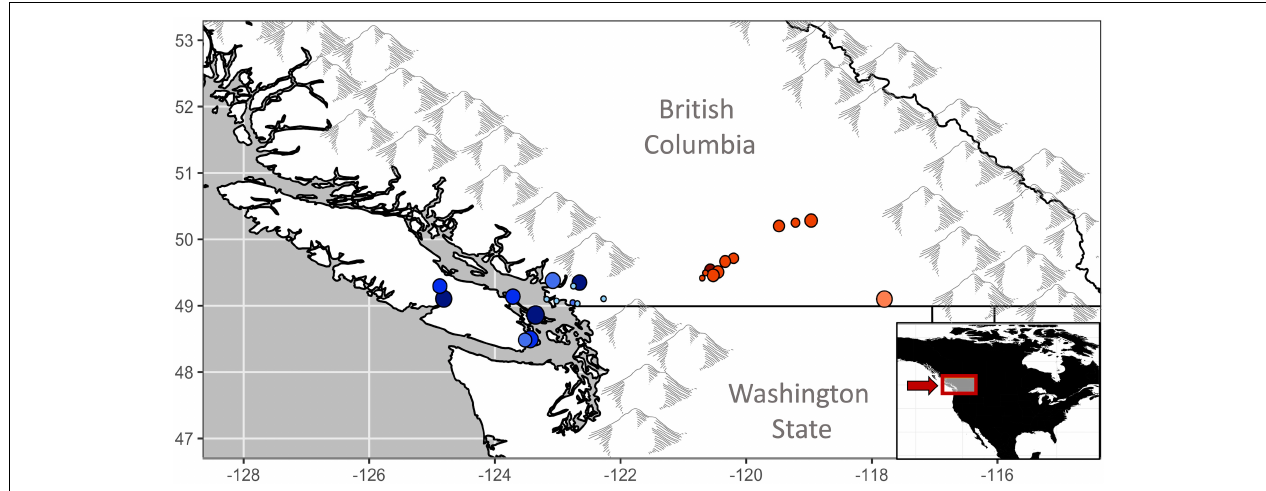
FIGURE 1 | Hummingbird monitoring project of BC mark-recapture locations in coastal (blue) and interior (red) regions of British Columbia, Canada. Clustered locations have been shifted ( < 8 km) for increased visibility. Point size reflects total years of banding effort, darker points reflect sites with higher Rufous hummingbird capture rates. Location details are additionally presented in Table 2 . TABLE 1 | Proposed drivers of variation in adult apparent annual survival for Rufous hummingbirds during the migratory period. Condition Variable assessed Predicted relationship